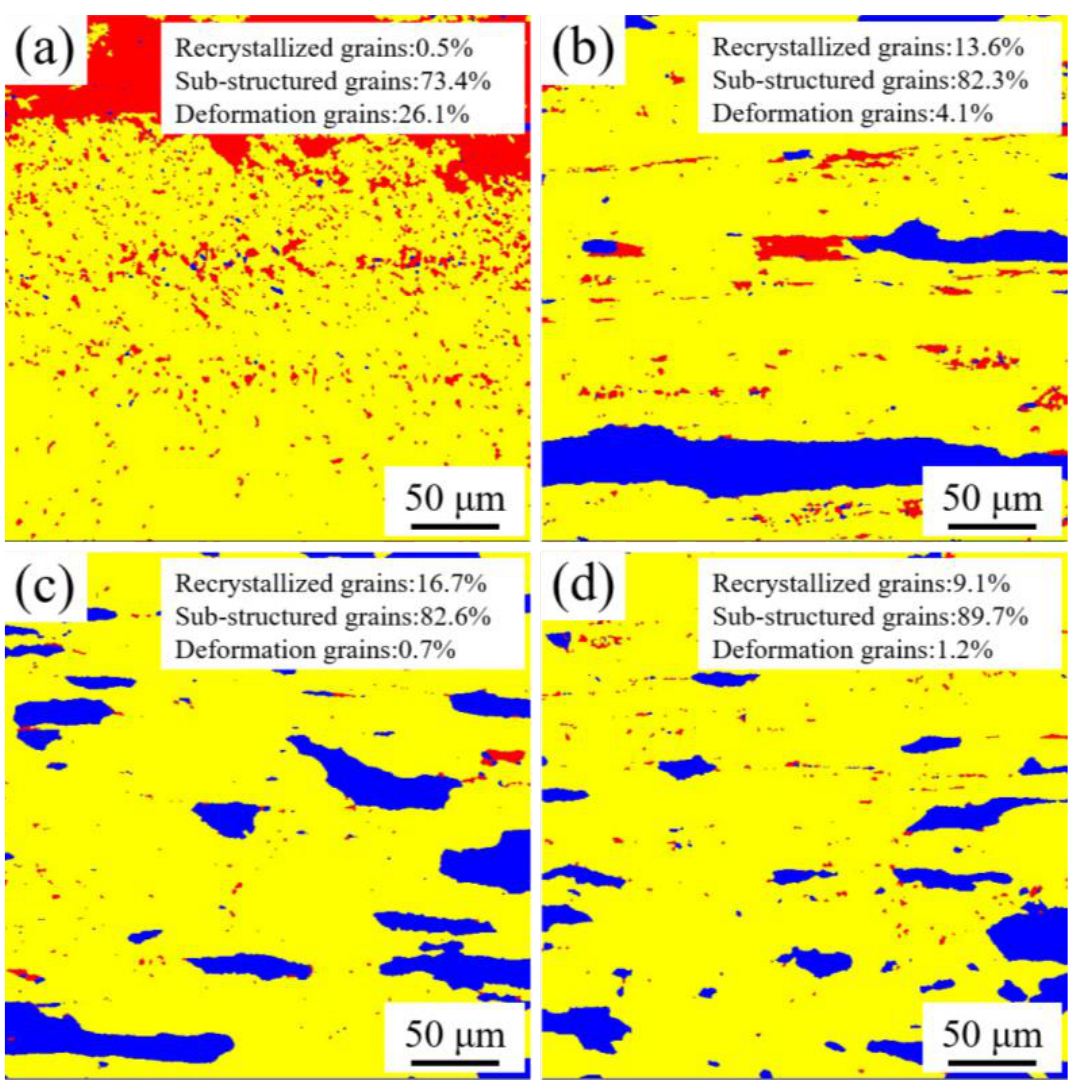
Figure 5. Microstructures of the alloys after rolling process ( a ) AL1; ( b ) AL2; ( c ) AL3; ( d ) AL4. The dynamic recrystallization degree of AL1 alloy is about 0.5% after the rolling process, as shown in Figure 5a. The deformation structure of the alloy changes with the increase of Ce content, as shown in Figure 5b. An incomplete recrystallization consisting of substructure grains, recrystallization grains, and deformation grains appears when the Ce content is 0.1%. The degree of recrystallization of AL2 alloy increases from 0.5% to 13.6%. When the Ce content increases to 0.2%, the degree of recrystallization of the alloy increases slightly, as shown in Figure 5c. However, when the Ce content reaches 0.3%, the degree of recrystallization of AL4 alloy decreases from 16.7% to 9.1%. Figure 6 illustrates the misorientation distributions and the fractions of HAGBs of AL1-AL4 alloys. The misorientation below 3 ◦ has been removed from Figure 6. It can be found that the fraction of LAGBs is much higher than that of HAGBs. For AL1 alloy, the average misorientation angle is 2.5 ◦ , and the fraction of HAGBs is 2.4% as shown in Figure 6a. When the Ce content increases from 0.1%, 0.2%, to 0.3%, the fractions of HAGBs are 5.6%, 10.3%, and 8.2%, respectively. Meanwhile, the average misorientation angles are 3.0 ◦ , 4.6 ◦ , and 4.0 ◦ , respectively, as illustrated in Figure